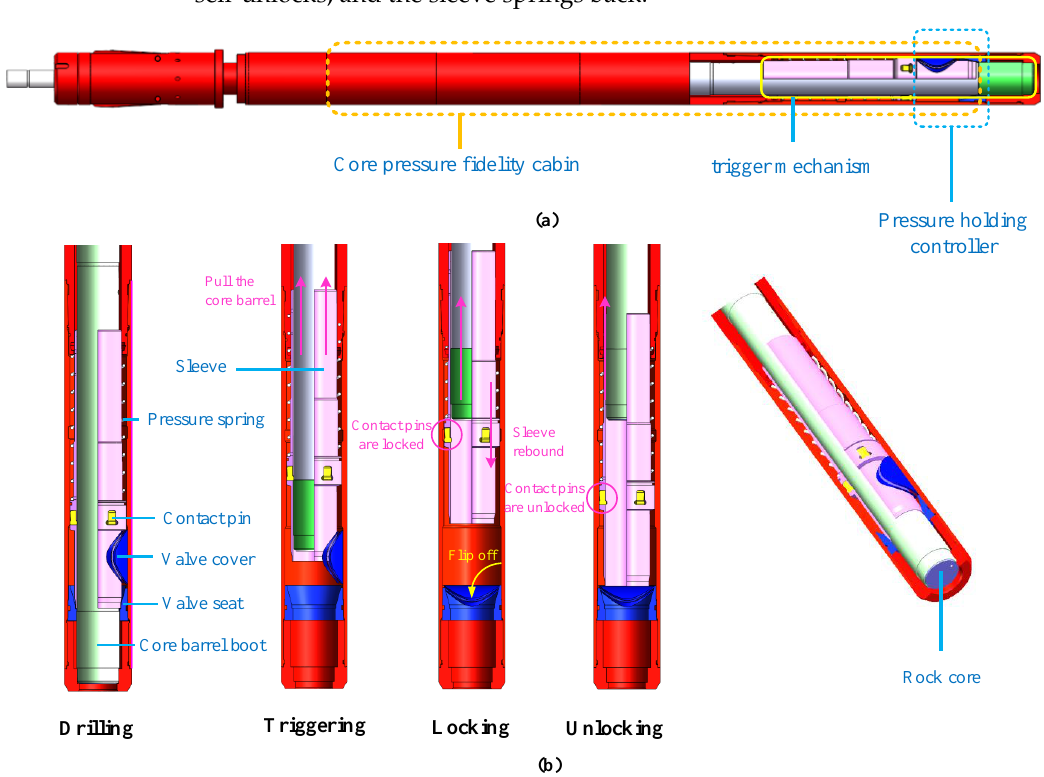
Figure 2. ( a ) Cross-sectional view of pressure-maintaining corer structure; ( b ) sectional view of pressure-maintaining coring process.